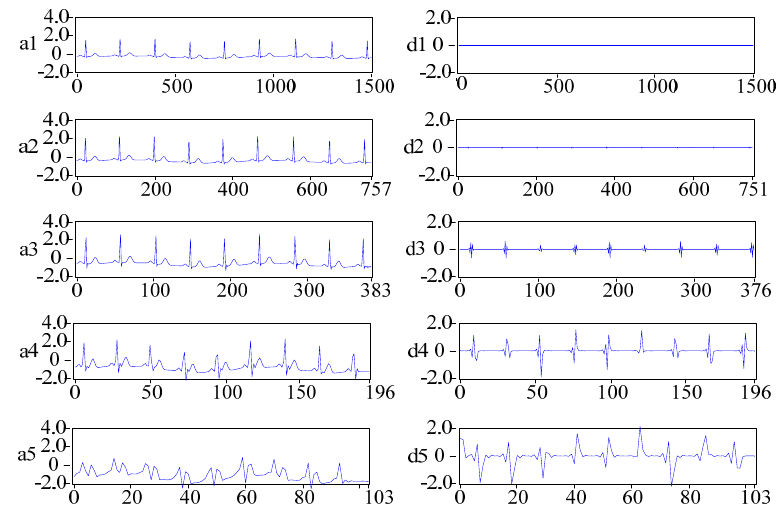
Figure 2. Results of wavelet transform (WT) for ECG denoising. ( a1 – a5 ) present the approximation coefficients of WT, and ( d1 – d5 ) present the detail coefficients of WT.